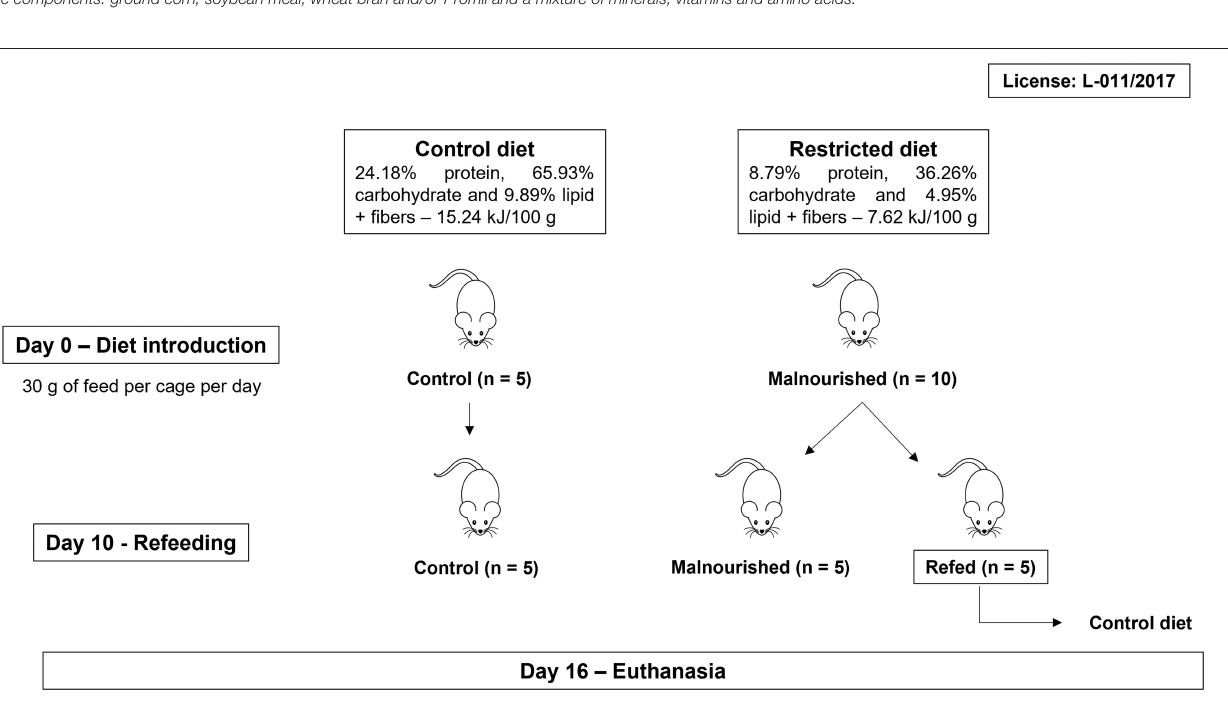
FIGURE 1 | Workflow of feeding protocol. BALB/c mice were randomly divided into two groups (control and malnourished groups). Mice in the control group received the Control diet, and mice in the malnourished group received the Restricted diet. On day 10, the malnourished group was randomly divided again, forming two groups: the malnourished group and the refed group. The malnourished group continuously received the Restricted diet, while the refed group received the Control diet. After 16 days, the mice were euthanized. Three independent experiments were performed with five animals per group, totalizing 15